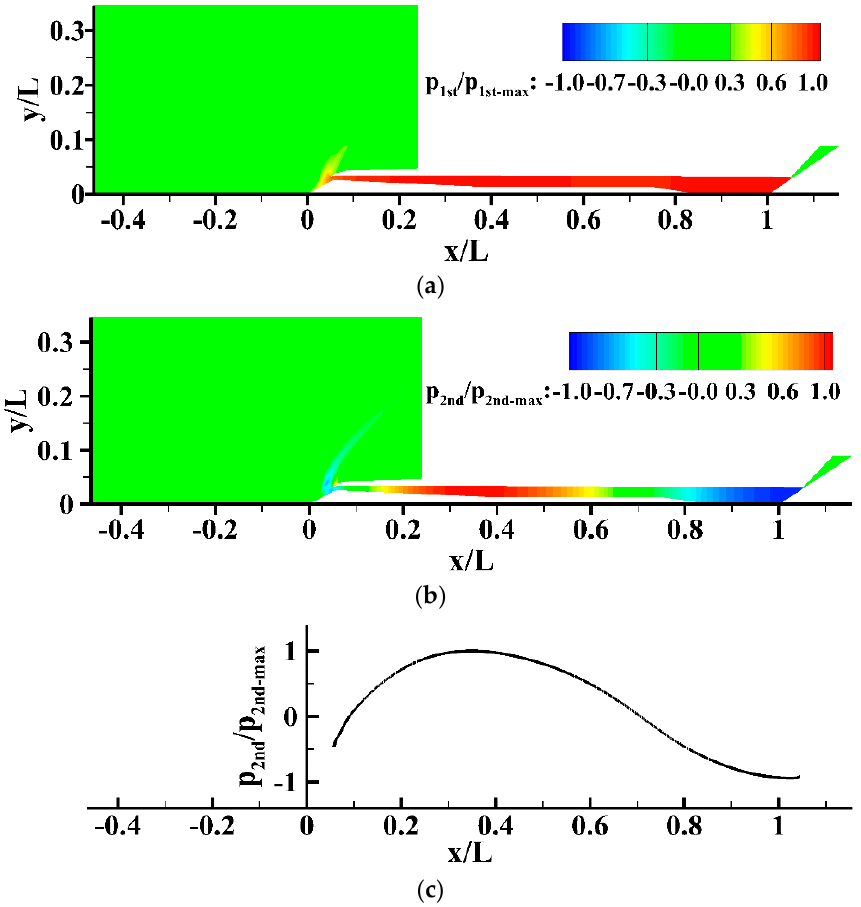
Figure 11. Instantaneous snapshots and distribution of the static pressure: ( a ) Snapshots of the first-order mode; ( b ) snapshots of the second-order mode; ( c ) static pressure fluctuation curve of the second-order mode.